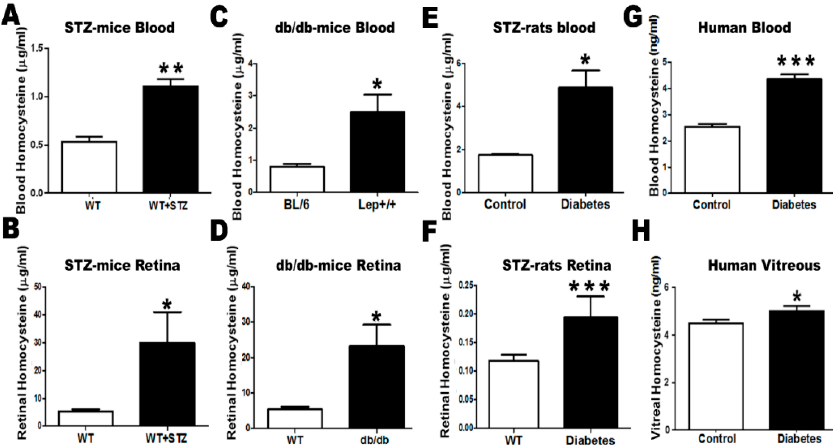
Figure 1. Assessment of Hcy level by enzyme-linked immuno sorbent assay (ELISA). ( A ) Blood and